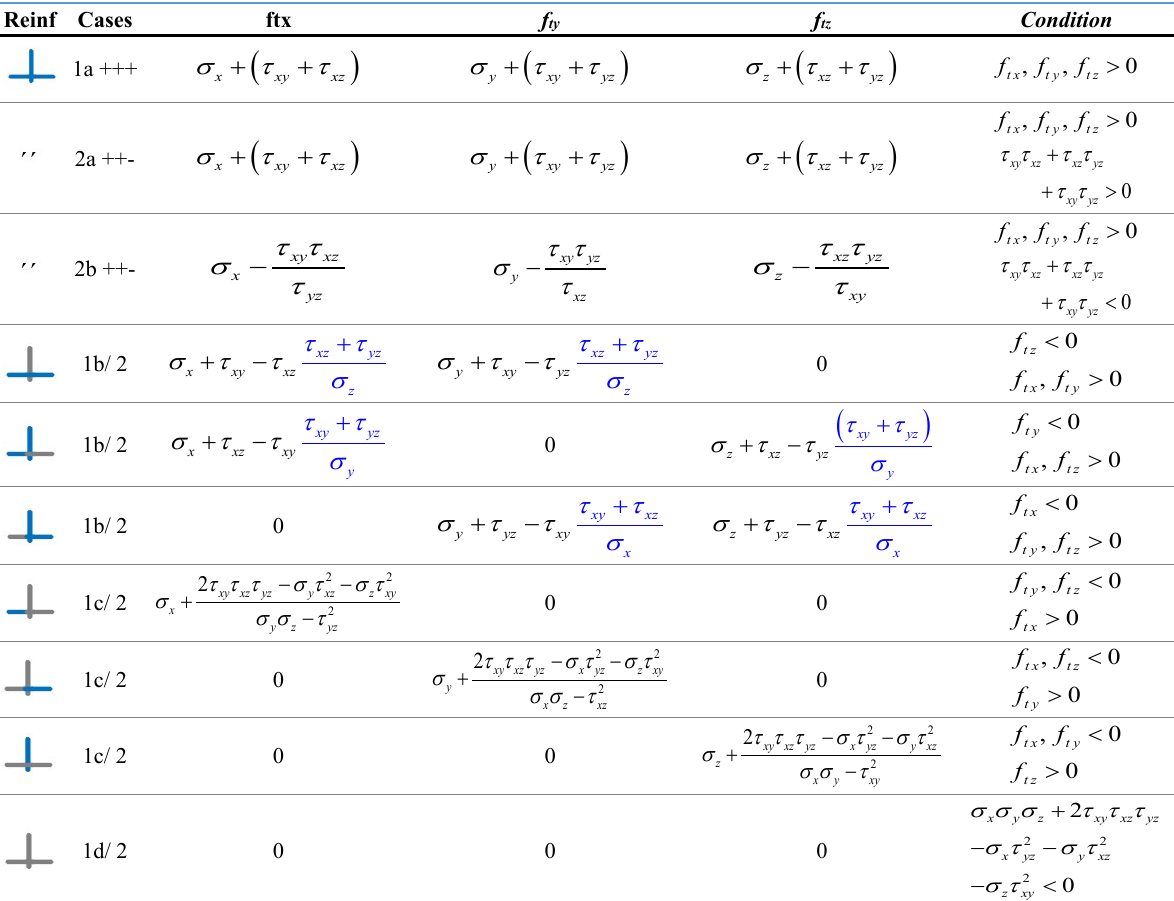
Figure 10. Comparison of concrete principal stress directions and the principal stress directions for the case of optimum reinforcement [12] Table 2. Summary of design equations for individual